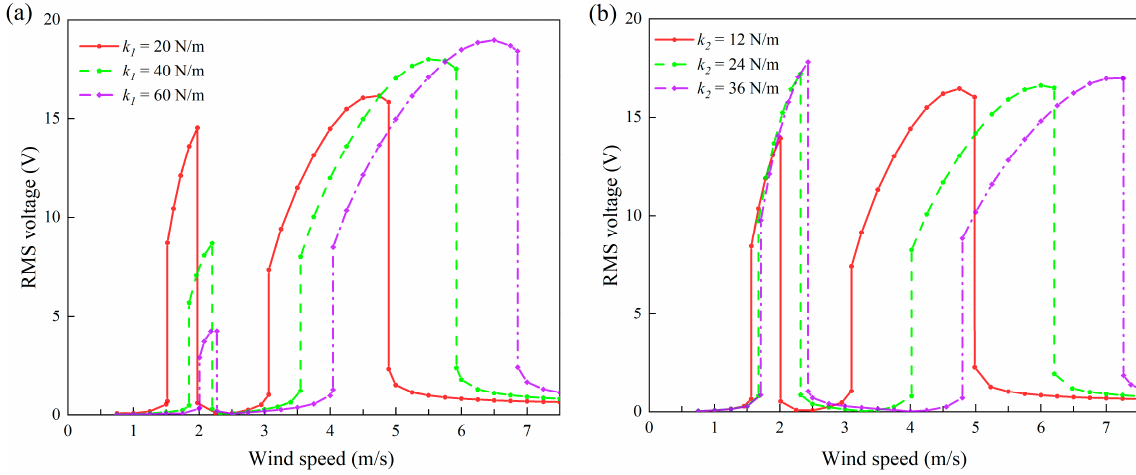
Figure 24. Effects of stiffnesses on the RMS voltage of the 2DOF VIVPEH: ( a ) k 1 ; ( b ) k 2 .